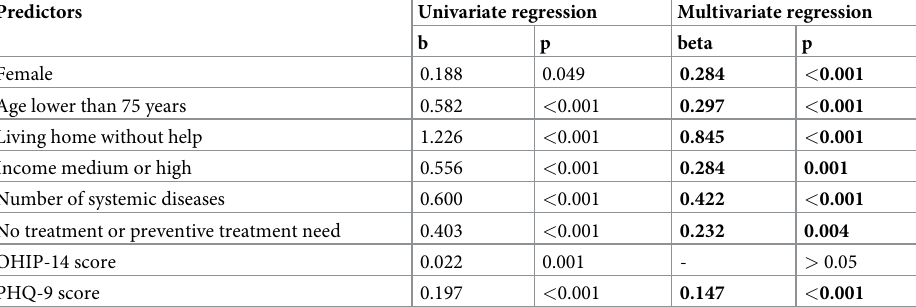
Table 6. Predictors of QoL assessed by EQ-5D questionnaire–values of linear regression